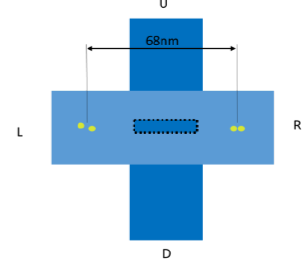
Figure 7. Schematized streptavidin-labeled origami construct.